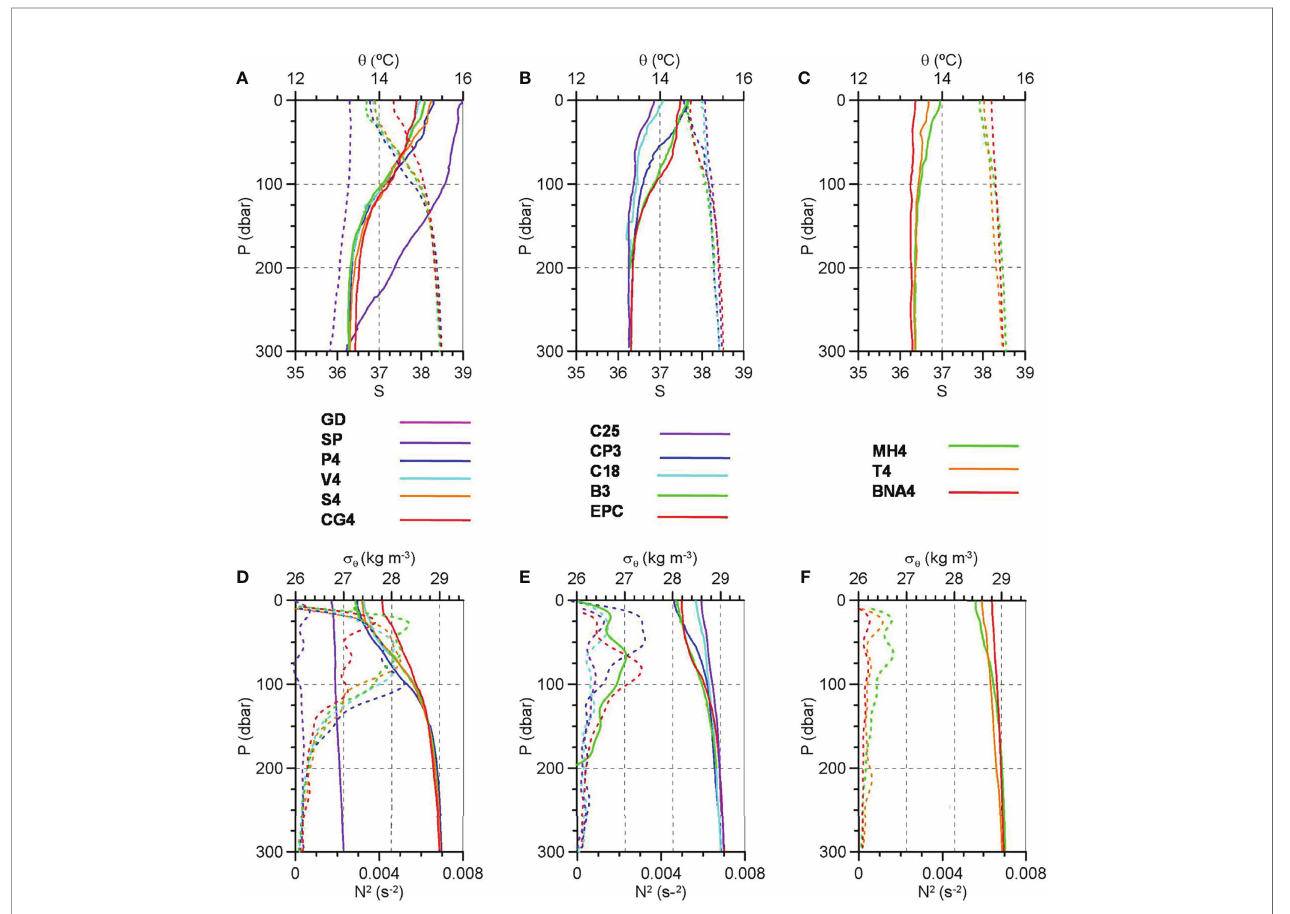
FIGURE 2 | Winter climatology computed for temperature (top panels, continuous lines), salinity (top panels, dashed lines), density (bottom panels, continuous lines), and N2 (bottom panels, dashed lines) vertical pro fi les at the selected oceanographic stations of the Gulf of Ca ́ diz and the Albora ́ n Sea (A , D) , Cape Palos and the south of the Balearic Islands (B, E) and those stations to the north of the Balearic Islands (C , F) . See color legend for station identi fi